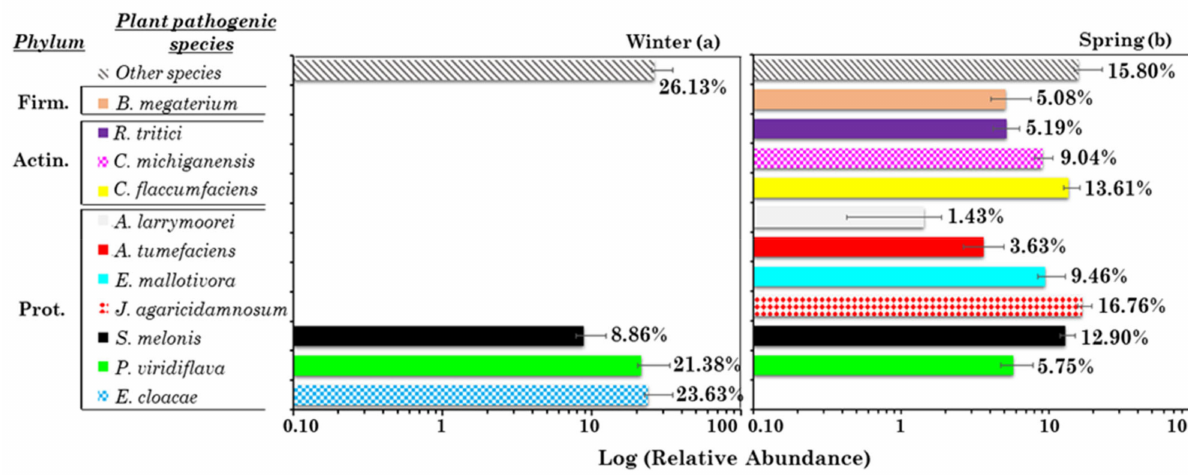
Figure 3. Mean percentage contribution (on a logarithmic scale) of the most abundant potential and pervasive plant pathogenic species in ( a ) winter and ( b ) spring: Bacillus megaterium ( B. megaterium ) , Rathayibacter tritici ( R. tritici ) ,